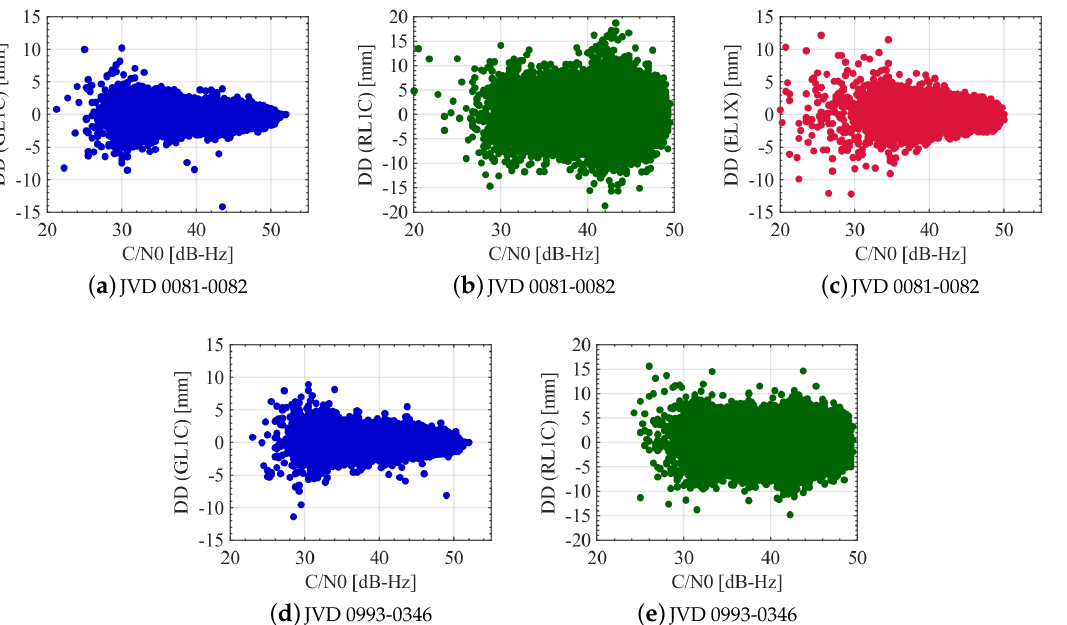
Figure 16. DDs of L1 carrier phase observations for different receiver combinations with respect to the received C/N 0 from all the satellites. GPS, GLONASS and Galileo noise levels are shown in blue, green and red colours,